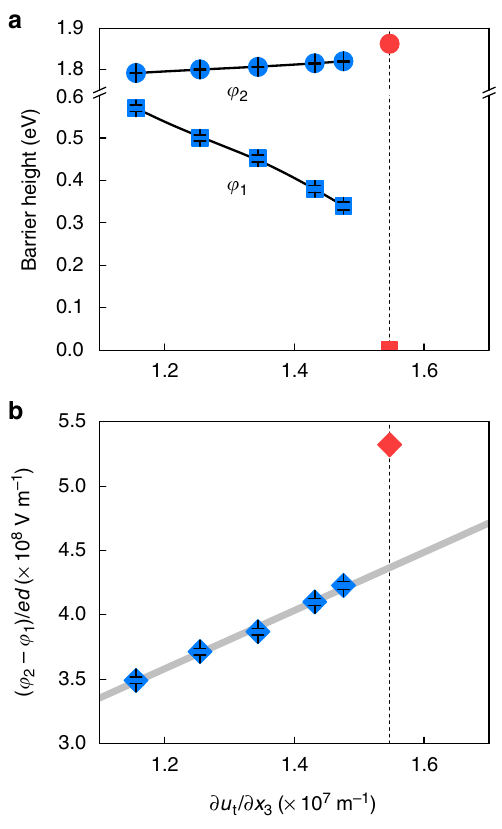
Fig. 4 Characterising fl exoelectricity in ultrathin SrTiO 3 . a The blue squares and circles indicate φ 1 and φ 2 , respectively, extracted by fi tting the tunnelling spectra to Equation (5). The error bars represent the standard deviations of the extracted barrier heights. The red square and circle represent φ 1 and φ 2 , respectively, for the triangular barrier at the critical ∂ u ∂ x φ – φ ed , calculated from a . The grey line shows a linear fi t to t / 3 . b ( 2 1 )/ the data. The error bars represent the standard deviations. Source data are provided as a Source Data fi